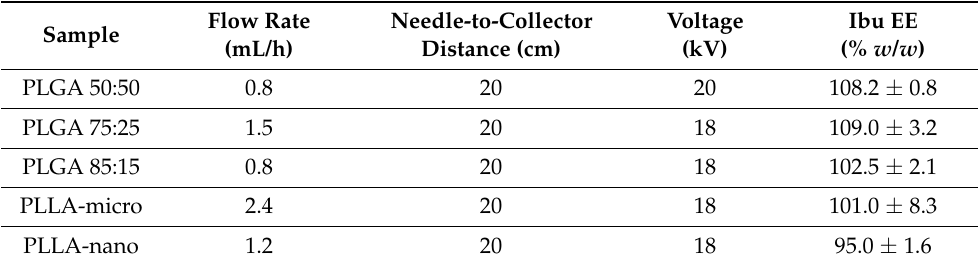
Table 1. Electrospinning parameters used to produce theoretical 5 wt% Ibu-loaded scaffolds, and drug encapsulation efficiency